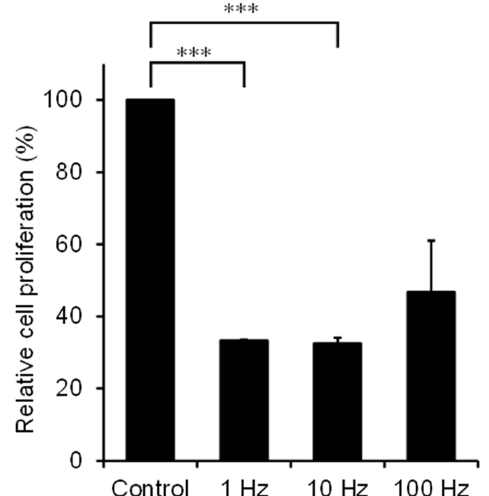
Figure 2. Cell proliferation inhibitory effect of US irradiation on TRAMP-C2 cells. TRAMP-C2 cells were irradiated with US, and cell proliferation was analyzed 24 h later by MTS assay ( n = 3, average ± SE bars). Compared with controls, cell proliferation was significantly suppressed by US irradiation at 1 and 10 Hz ( p < 0.0001, respectively) (***: p <